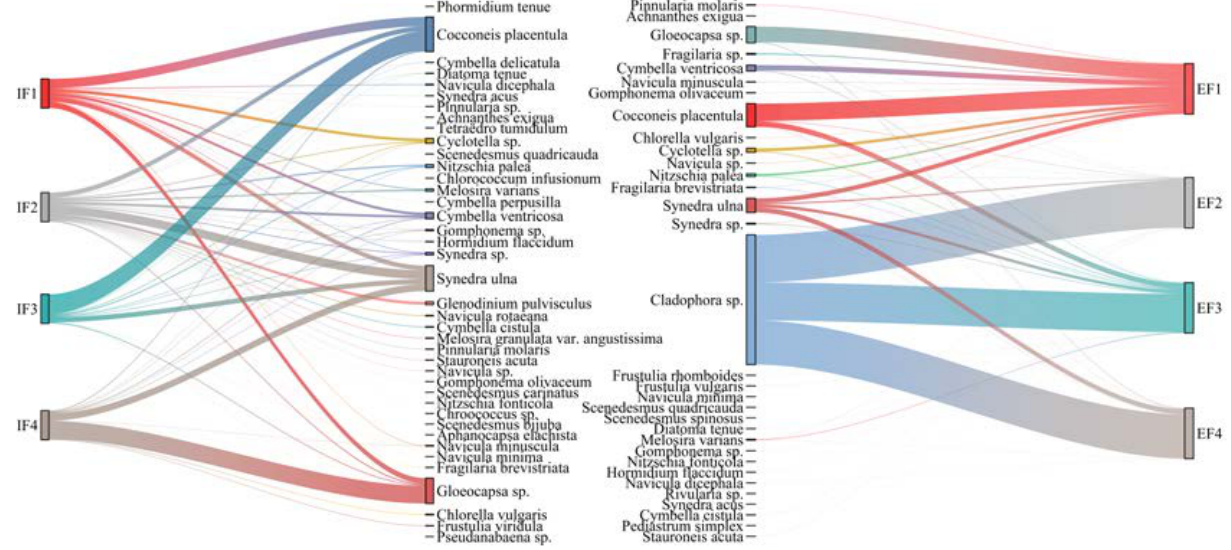
Figure 4. Sankey diagram of the abundance of benthic algae in four flow velocity gradient sections before and after the experiment.